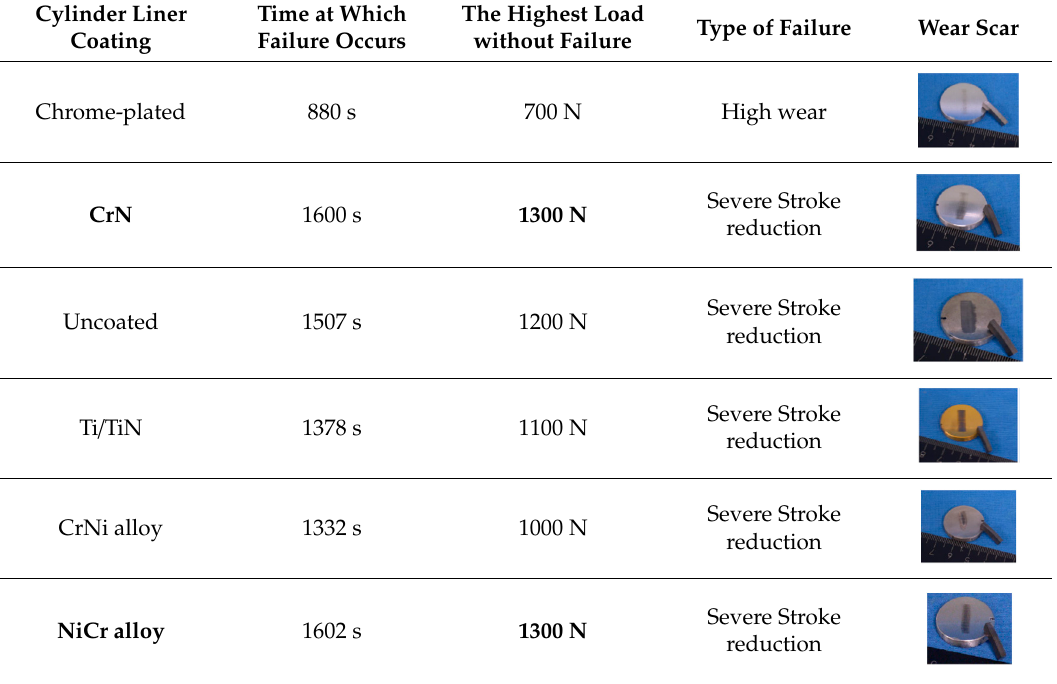
Table 3. Extreme pressure test results for different cylinder liner coatings against nitrided piston rings. Cylinder Liner Time at Which Coating Chrome-plated 880 s